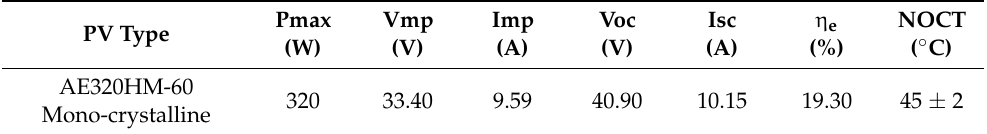
Table 1. PV module technical characteristics applied to